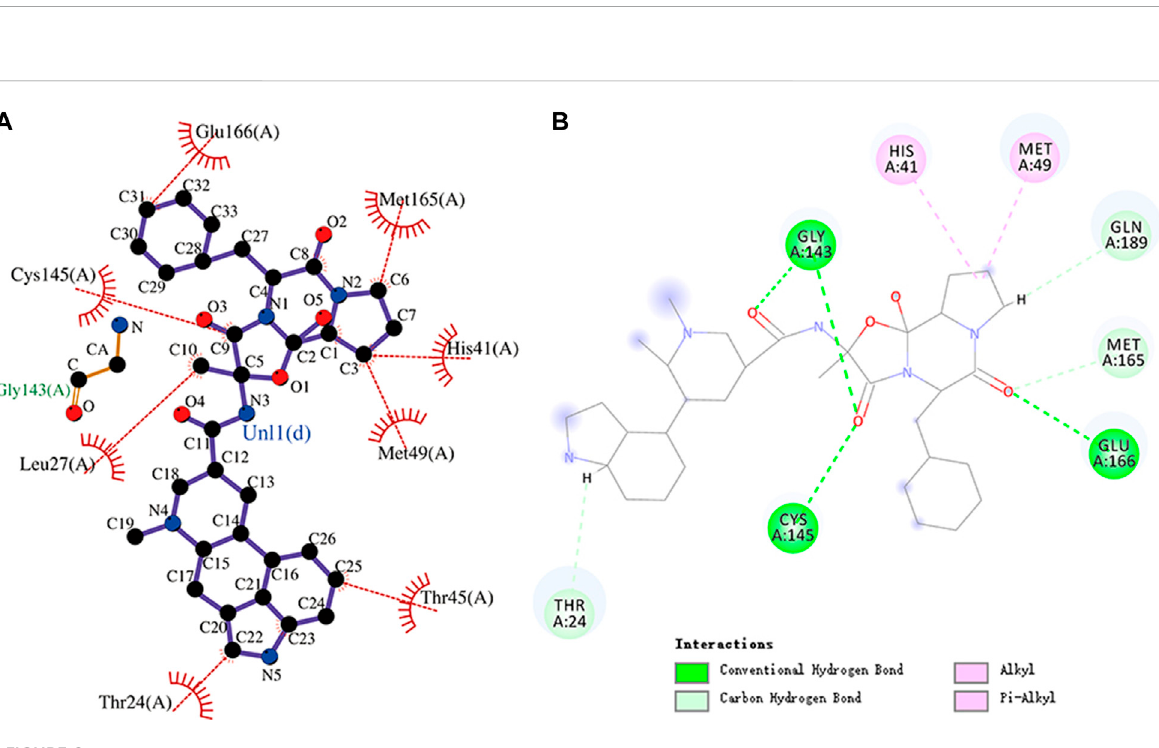
FIGURE 8 (A) Hydrophobic interaction between M pro and dihydroergotamine and (B) two-dimensional plot of dihydroergotamine interaction with the amino acid